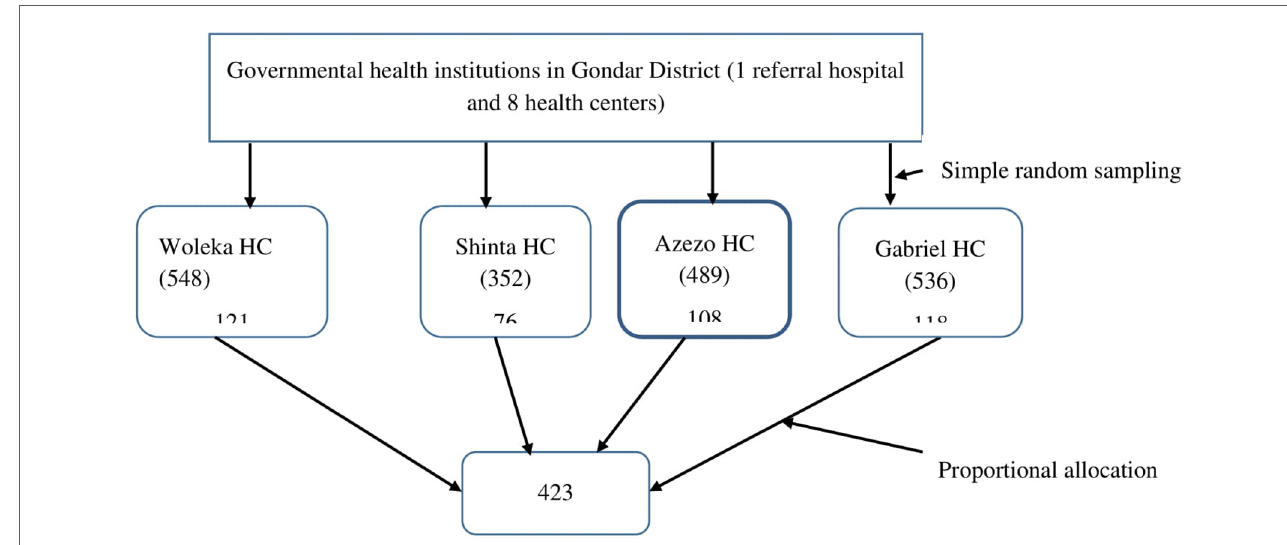
FIGURE 1 Selection of pregnant women (sample size) visiting ANC services at governmental health centers in Gondar District, Gondar, Ethiopia,